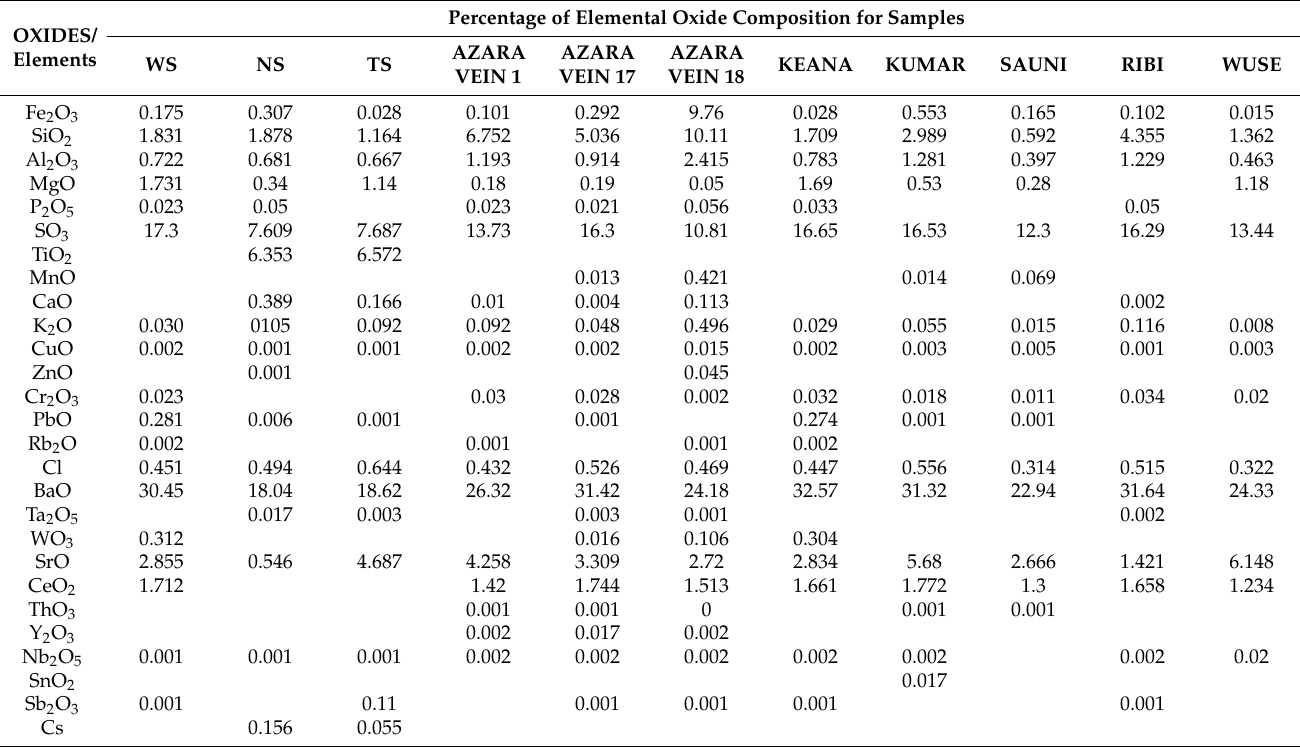
Table 2. EDXRF elemental oxide percentage composition of the samples from different mining sites. OXIDES/ Elements